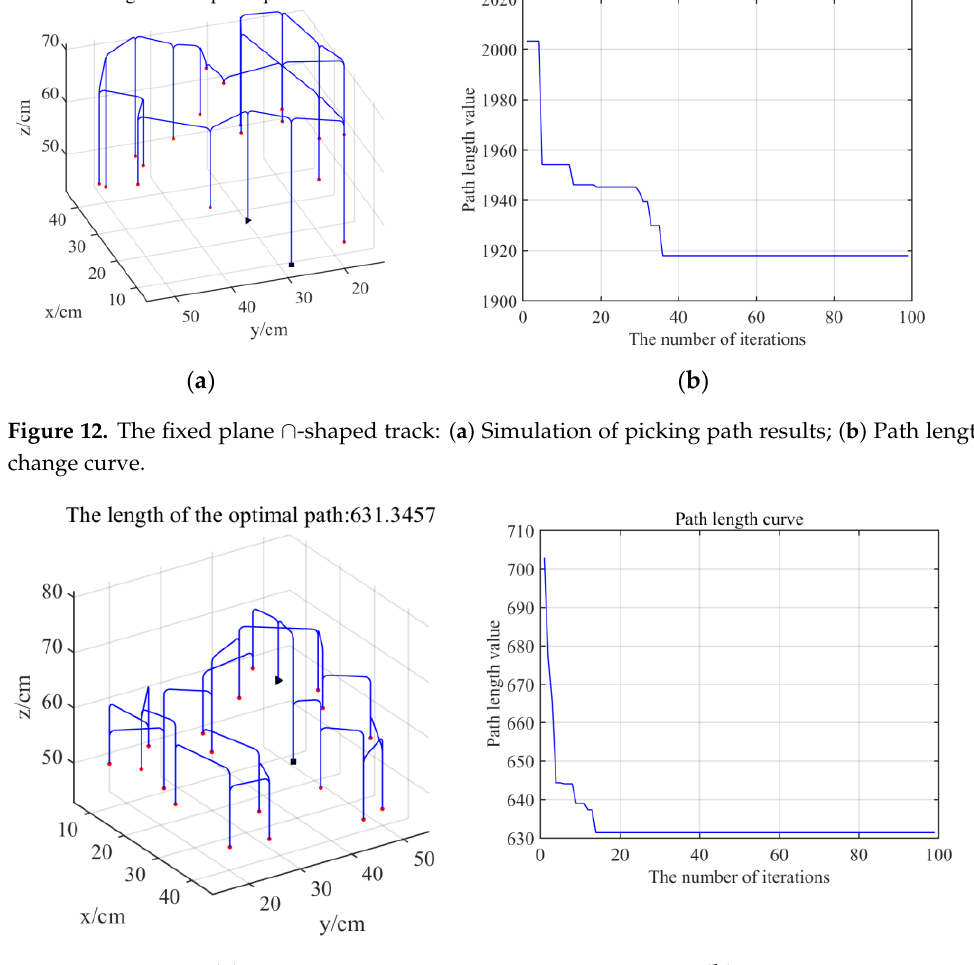
14 of 20 Figure 10. Simulation results of traditional ACA: ( a ) Path planning results; ( b ) Path length change curve; ( c ) Sum of waiting times of shortest paths. ( a ) ( c ) Figure 11. Simulation results of ACA with angle induction factor: ( a ) Path planning results; ( b ) Path length change curve; ( c ) Sum of the rotation time of shortest paths. From the comparison between Figure 10 and Figure 11, it can be seen that the path planned by the ACA with the angle induction factor is not much different from the short- est path length and the response speed of the algorithm planned by the traditional ACA. However, in the picking sequence planned by the ACA with the angle induction factor, the tilting angle difference between the safflower bulbs is much smaller than that of the traditional ACA, and the rotation time of the end-effector is shortened by 0.312 s. 4.2. Comparative Experiment of Improved Picking Track Considering that the average diameter of safflower bulb is 2.76 cm, the radius r of the transition arc should be smaller than the radius of safflower bulbs, otherwise, the move- ment between two bulbs cannot be accomplished with the fixed height ∩ -shaped track. Therefore, the radius r of the transition arc of the two safflower bulbs picking track is set as 1 cm in this paper. Considering that the maximum height difference between adjacent fruit bulbs is 6.8 cm, the end-effector should be slightly higher than the higher safflower